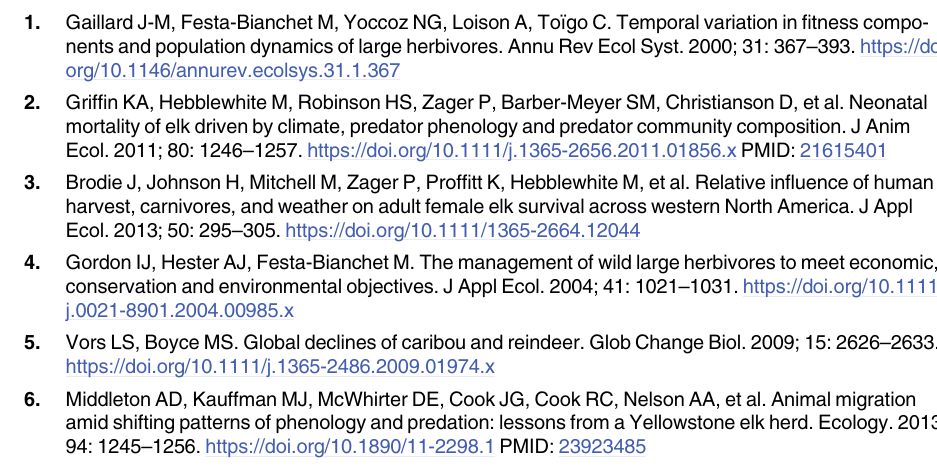
S1 Table. Summary statistics for covariates across all hunting districts and years. S2 Table. Summaries of the approximate posterior distributions for regression coeffi-